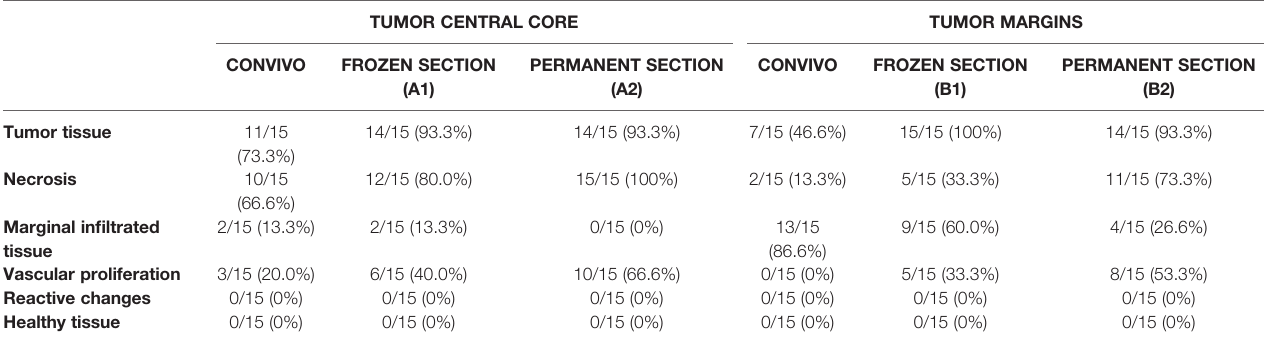
TABLE 3 | Detailed list of morphological patterns analyzed in CONVIVO ® , frozen section, and permanent section images, in both tumor central core and tumor margins